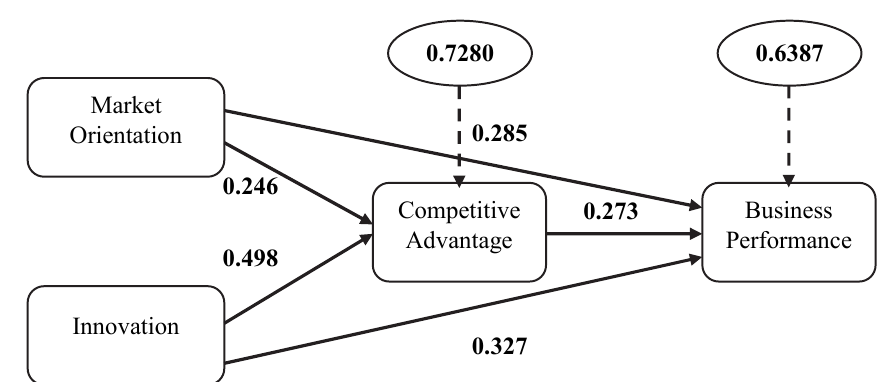
Fig. 1. The Structural Model Influence of Path Analysis